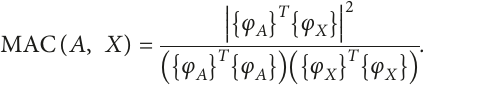
Figure 6: Results of cluster